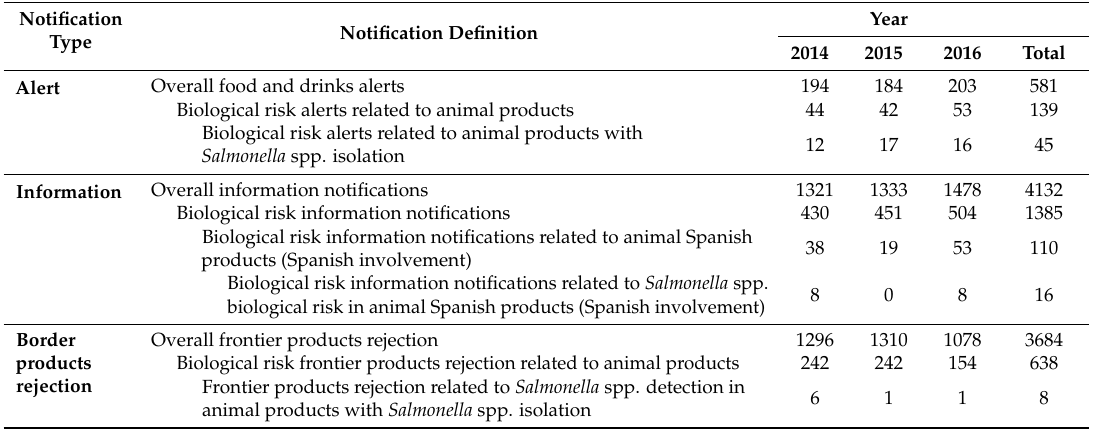
Table 4. Overall biological risks and Salmonella spp. related notifications reported by SCIRI.